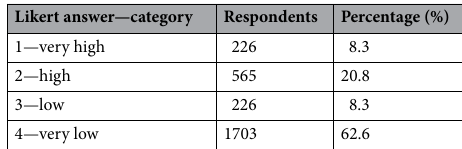
Table 2. Awareness level in Benin City of the repercussions of indiscriminate waste disposal to the